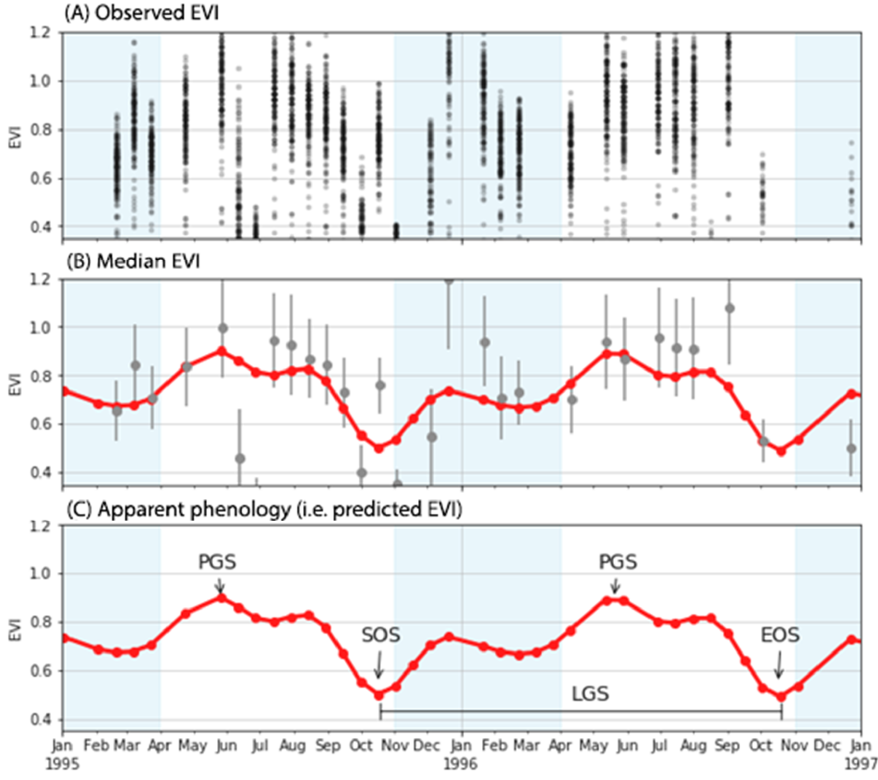
Figure 3. Panel ( A ) shows every available Enhanced Vegetation Index (EVI) observation for every pixel in the 17-ha region of interest from February 1995 to December 1996 for the Gladstone region. Panel ( B ) shows the median and standard deviation of the observed EVI values in grey dots and lines respectively, and the apparent phenology (i.e., GAM) in red. Panel ( C ) shows the apparent phenology, the definitions of start and end of season (SOS, EOS), peak growing season (PGS) and length of the growing season (LGS). Shaded areas represent the wet season months.